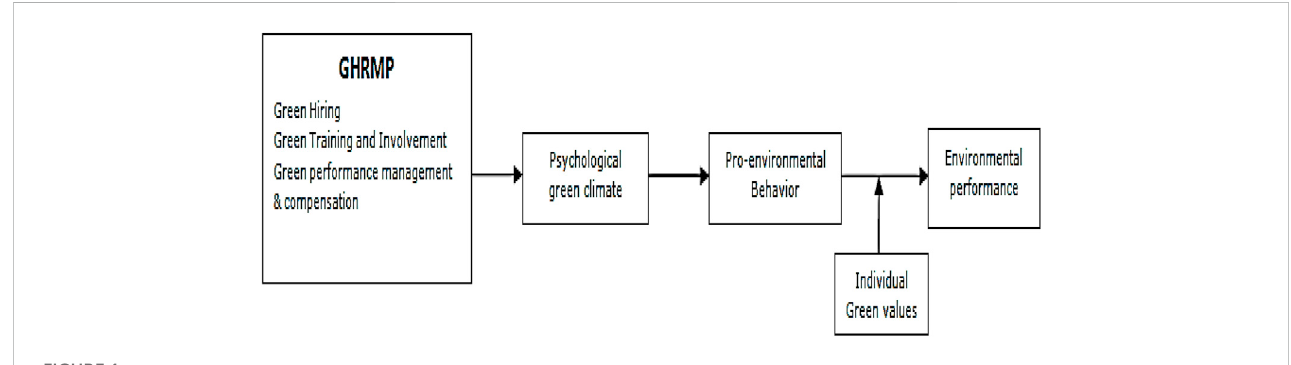
FIGURE 1 Conceptual